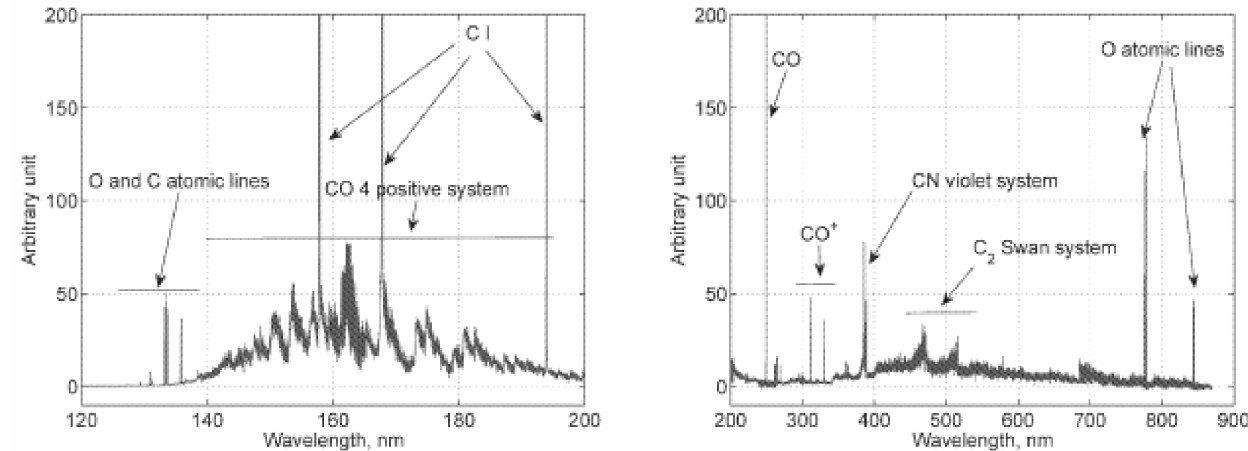
Figure 44. Radiation systems and lines in PHEDRA (from